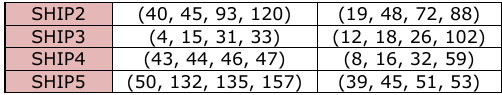
Table 1. “Number of Containers in each ship”.